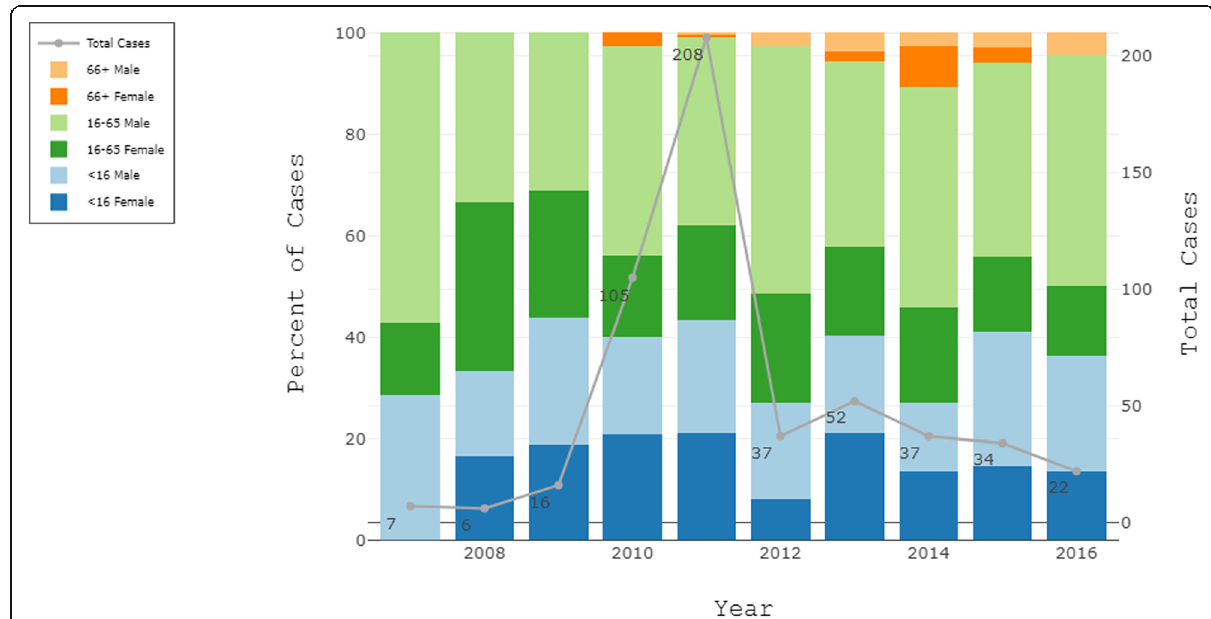
Fig. 2 Age-sex distribution of CL cases in four clinics located in Moyobamba and Rioja provinces, Peru, Jan 2007 through July 2016. Data availability: Pueblo Libre, 01/2007 – 07/2016; Soritor, 01/09 – 07/2016; Yuracyacu and El Valle de la Conquista (shared registry), 05/2010 – 07/2016, 2013